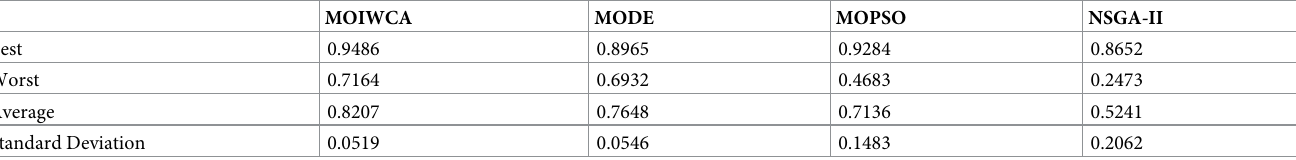
Table 7. Comparison of HV metric for different